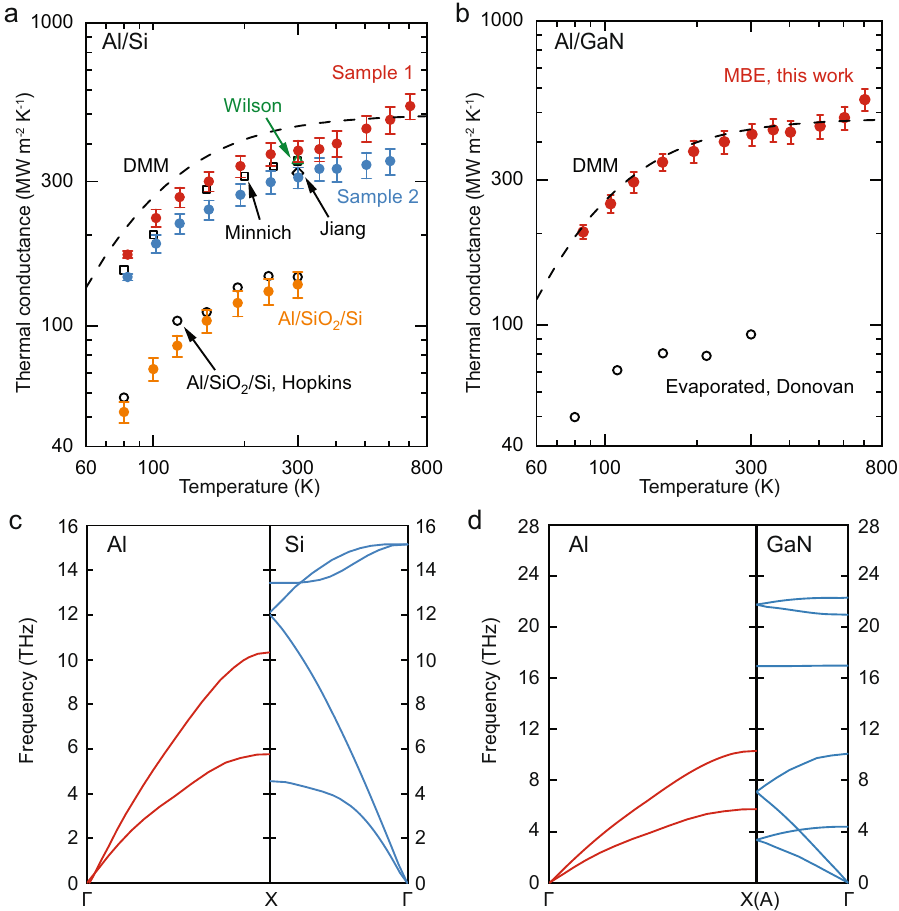
Fig. 1 | Thermal conductance of Al/Si and Al/GaN interfaces. a Thermal con- ductanceofAl/SiSample1(redspheres)andSample2(bluespheres).Blackdashed lineisinterfacethermalconductancecalculatedbyDMM.Forcomparison,weshow previously measured Al/Si thermal conductance in open squares by Minnich 39 , triangle by Wilson 40 , and diamond by Jiang 41 . Yellow solid spheres are measured thermal conductance of Al/Si with a native oxide layer, compared with the results by Hopkins, shown in open circles 14 . b Thermal conductance of Al/GaN interface